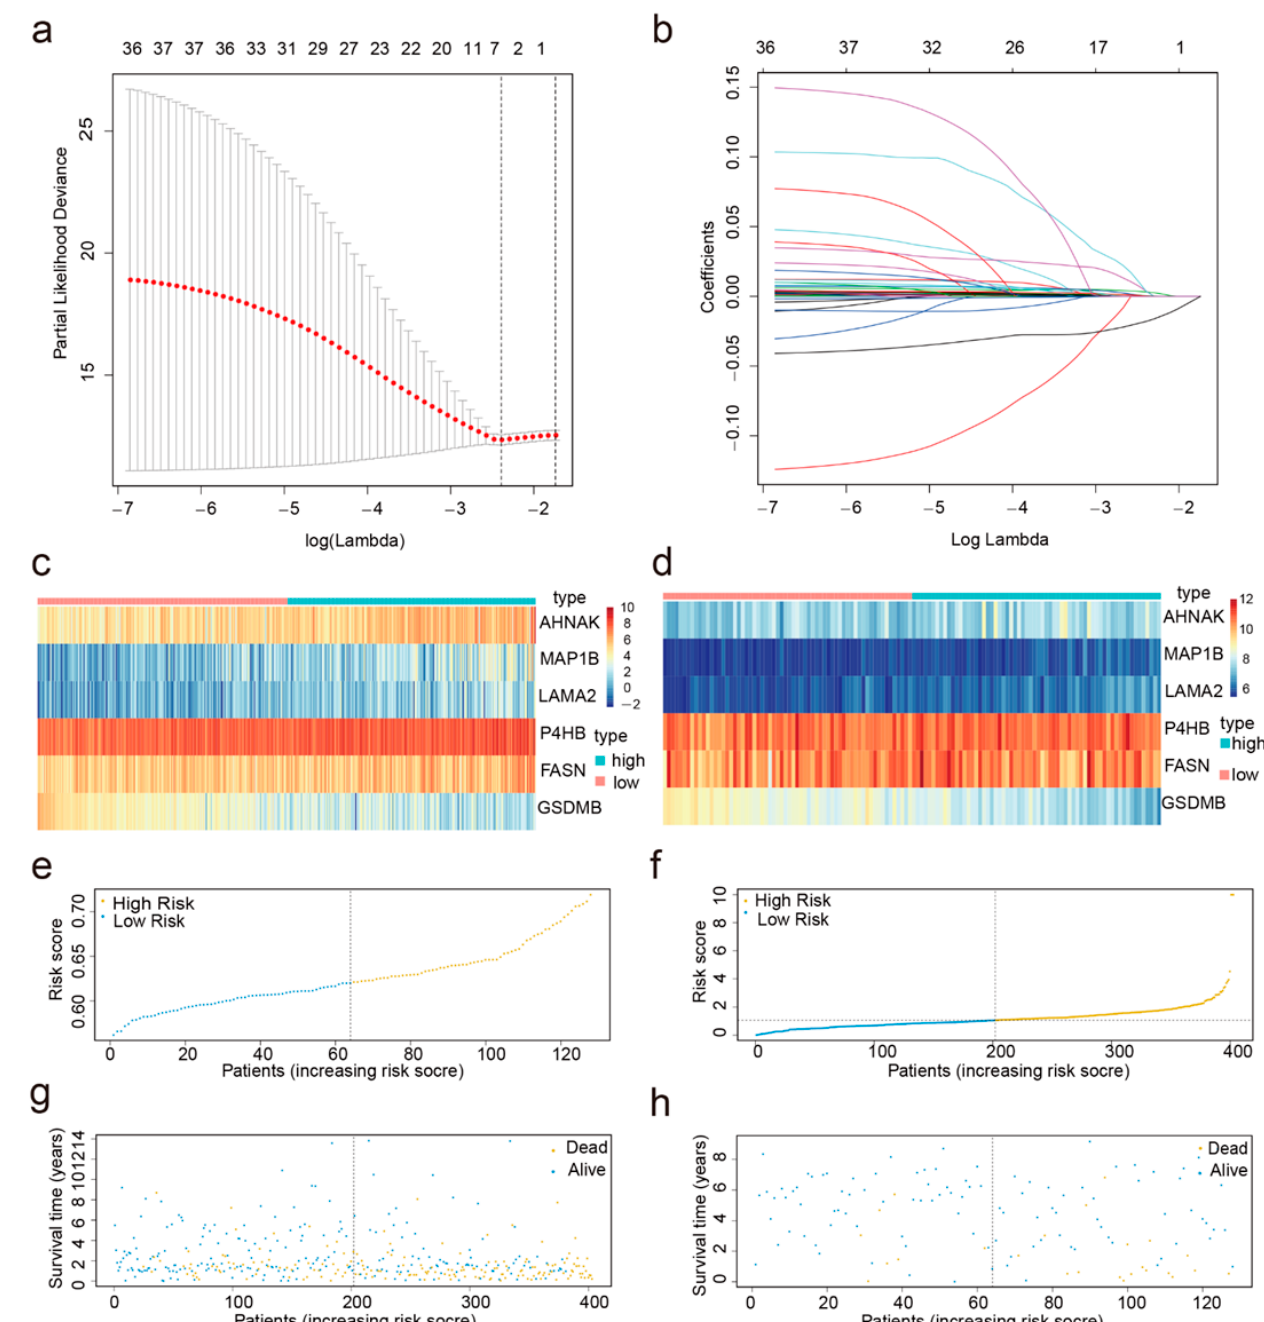
Figure 1. Predictor selection using the most minor absolute shrinkage and selection operator (LASSO). ( a ) Parameter (lambda) selec- tion by the LASSO model adopted 10-fold cross-validation via minimum criteria; ( b ) LASSO coefficient profile plot of the six RNA- binding protein (RBP) gene pairs against the log (lambda) sequence risk curve of training and test sets; ( c ) heat map of the six RBPs for the high- and low-risk groups in the training cohort; ( d ) heat map of the six RBPs for the high- and low-risk groups in the valida- tion cohort; ( e ) risk score distribution for the training cohort; ( f ) risk score distribution for the validation cohort; ( g ) distribution of the survival status of the training cohort; ( h ) survival status distribution of the variation cohort.